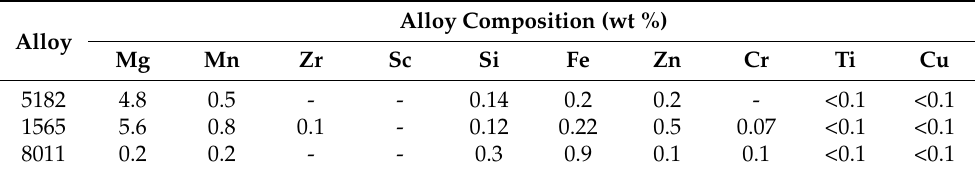
Table 1. Chemical compositions of the alloys